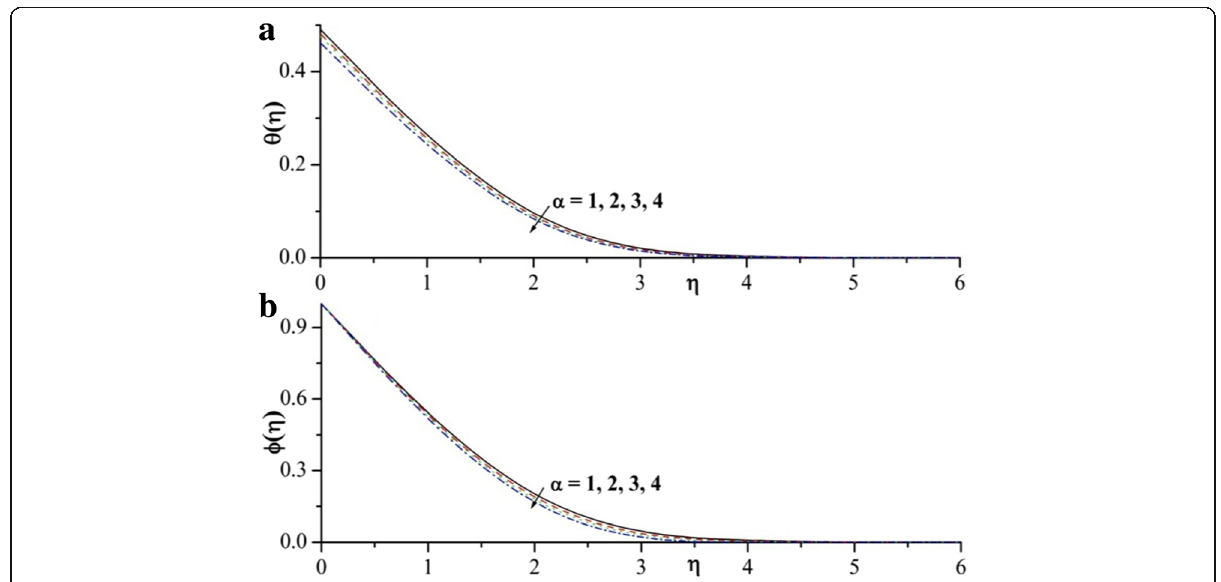
Fig. 7 a Temperature and b nanoparticle concentration profiles for variable values of